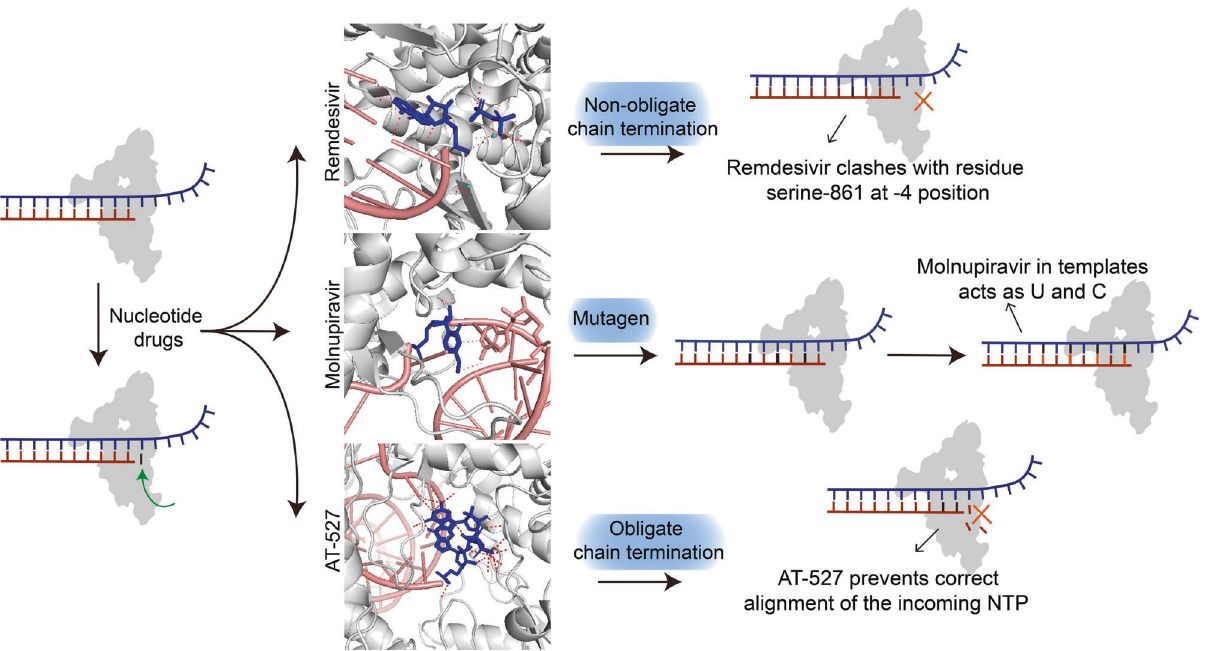
Fig. 3 Antiviral mechanisms of nucleotide drugs. The triphosphate form of remdesivir acts as a non-obligate chain terminator to exert an inhibition effect (Protein Data Bank entries 7VB2 19 ). The active form of molnupiravir can be directly incorporated into RNA as a substrate instead of cytidine triphosphate (C) or uridine triphosphate (U), thereby leading to mutated RNA products (Protein Data Bank entry 7OZU 38 ). The triphosphate form of AT-527 (AT-9010) incorporates at the 3 ′ end of the RNA product, causing termination of RNA synthesis (Protein Data Bank entry 7ED5 51